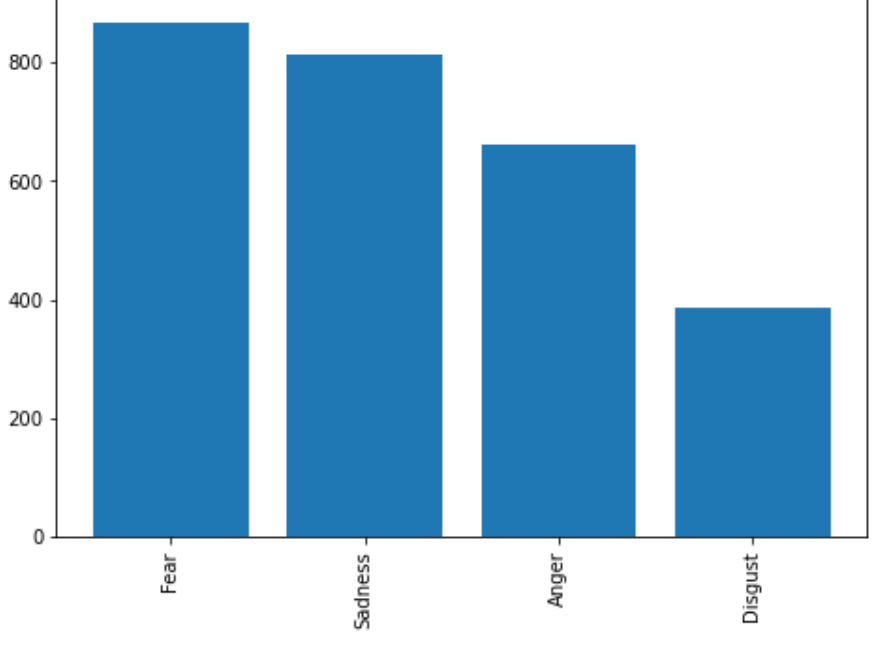
Figure 4. The order of the dominant negative emotions detected.